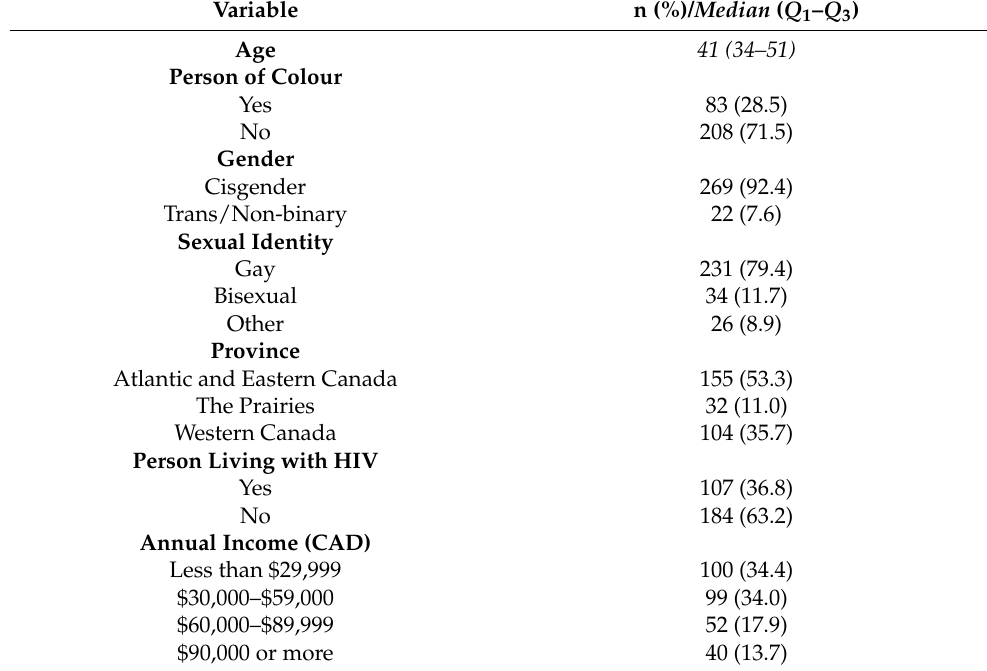
Table 1. Sample Demographic